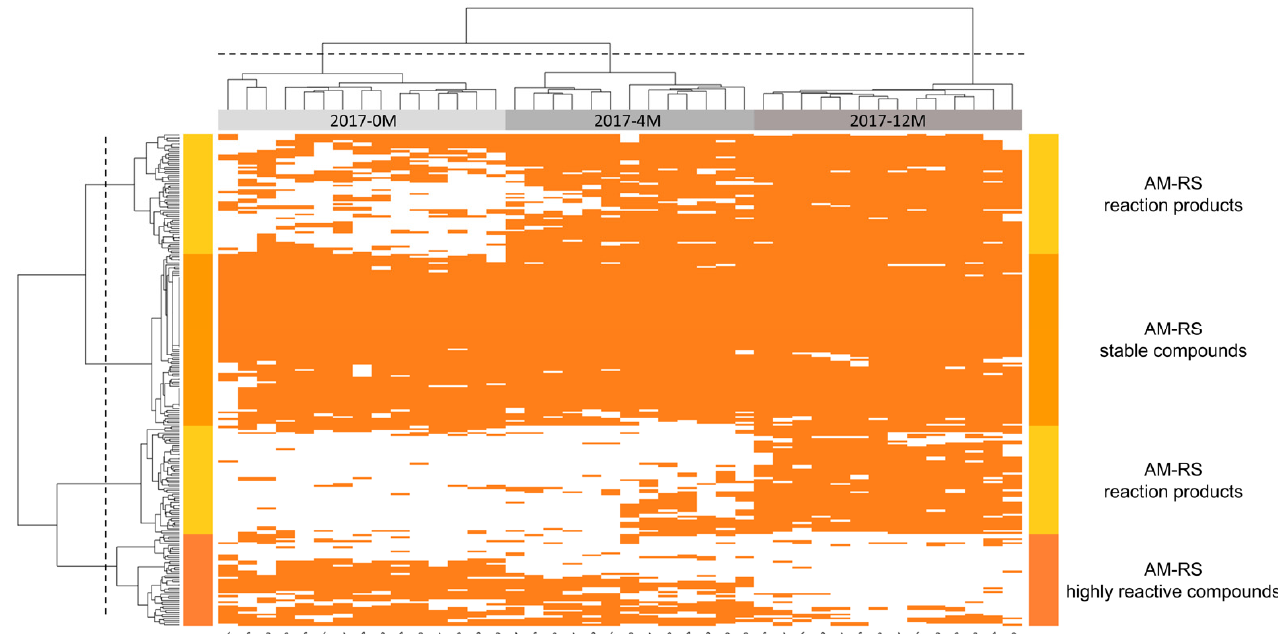
Figure 3. Heatmap of AM-RS dynamic molecular compositions during barrel aging. White areas represent undetected compounds, and orange areas represent detected compounds. Hierarchical clustering analysis allows for the discrimination of three groups of AM-RS compounds: stable compounds, highly reactive compounds, and reaction products.